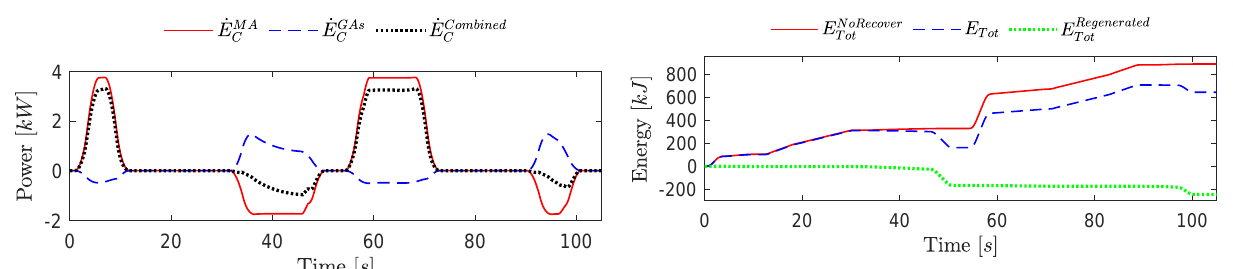
Figure 20: The total energy consumption of all actuators.